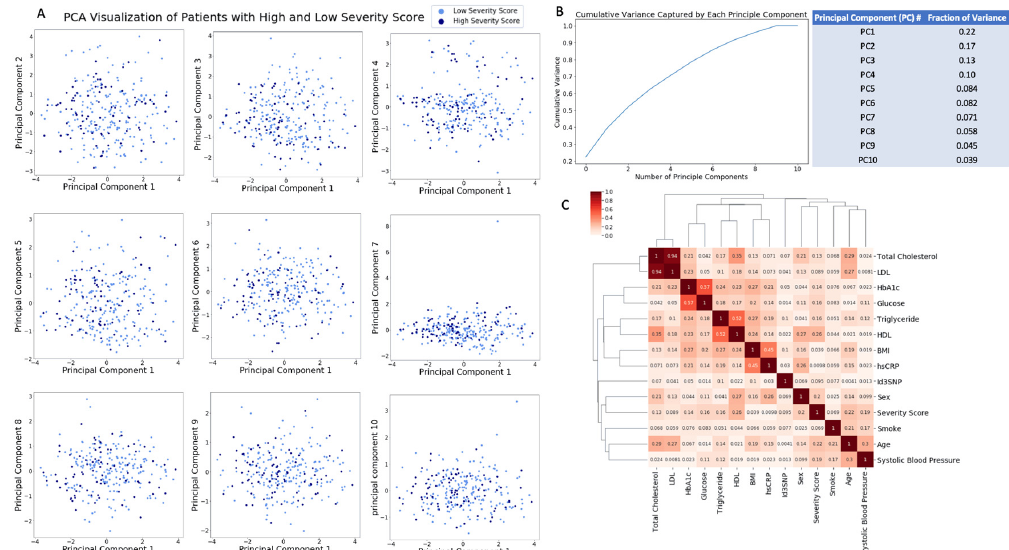
Figure 2. PCA and correlation matrix of patients with high and low severity score generated using conventional risk factors and Id3 SNP. PCA plots between PC1 and PC2-PC10 ( A ) and low fraction of variance captured by each principal component (PC) ( B ) suggested that patients with high and low severity score cannot be di ff erentiated by using PCA based on their conventional risk factors and Id3 SNPs. Correlation matrix also demonstrates low-intermediate correlation between severity score and conventional risk factors and Id3 SNP ( C ). Both PCA and correlation matrix analysis indicates a challenge in developing a model / strategy to classify patients into high and low risk severity